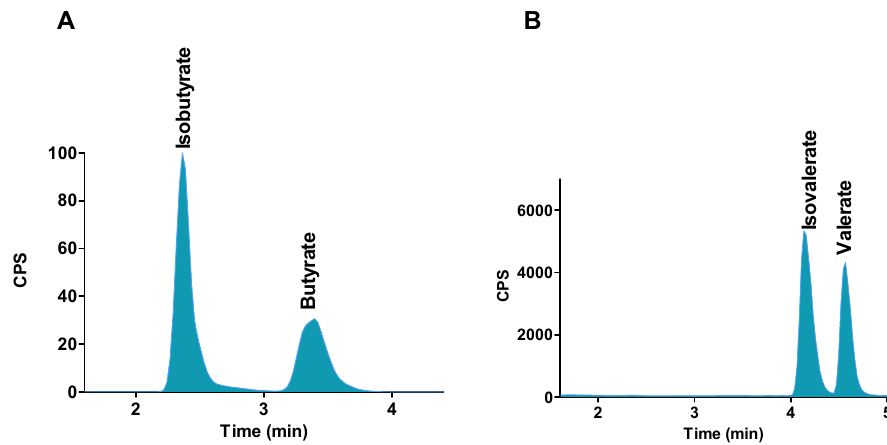
Figure 1. Separation of isomers and stereoisomers of SCFAs using PGC column. ( A ) Isobutyrate and butyrate, ( B ) Isovalerate and valerate.